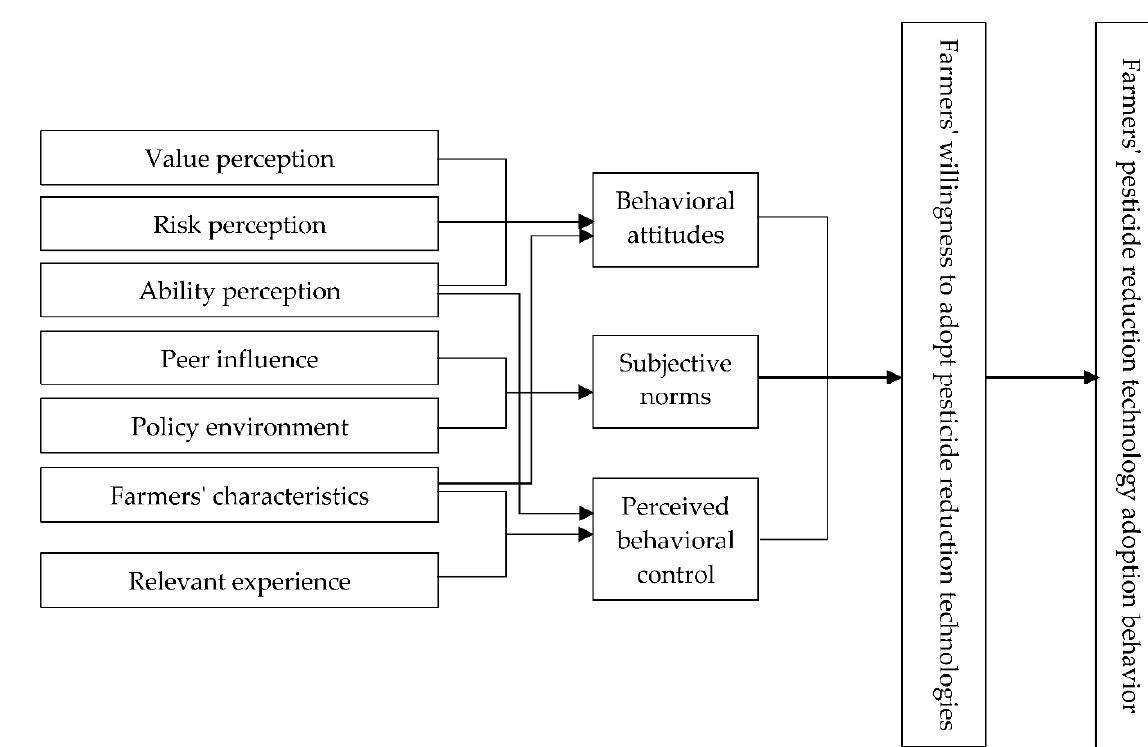
Figure 2. Theoretical framework of farmers' response behavior to adopting pesticide reduction technology.